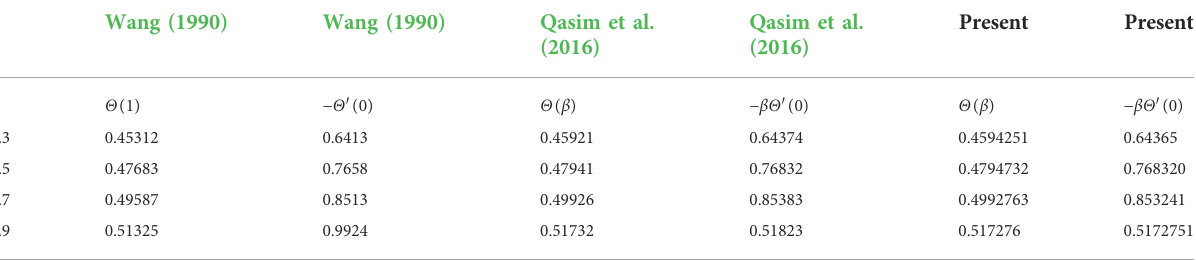
TABLE 2 Comparison between the published work and present work for the surface and wall temperature gradients considering common factors using the regular fl uid having Pr (cid:1) 7 . 56. Note that they used small and variable values of the Prandtl number.